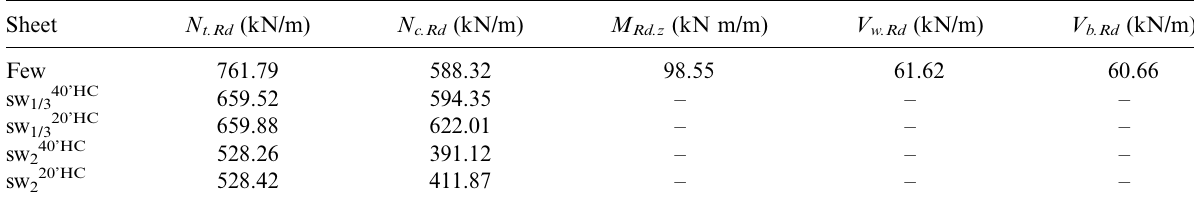
Table 13. Design strengths for sheets Sheet